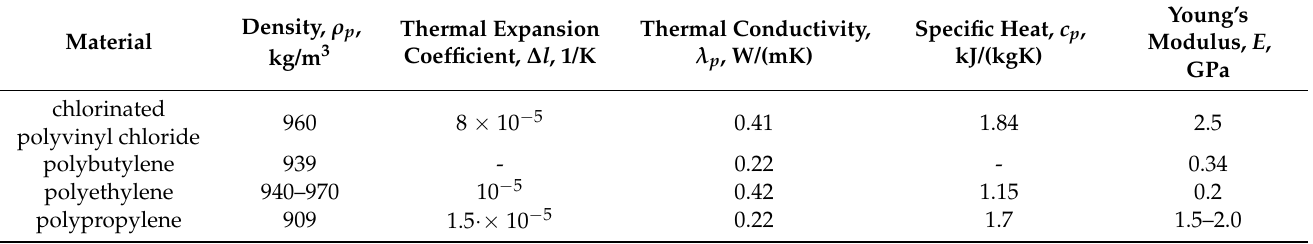
Table 2. List of basic properties of materials used in borehole heat